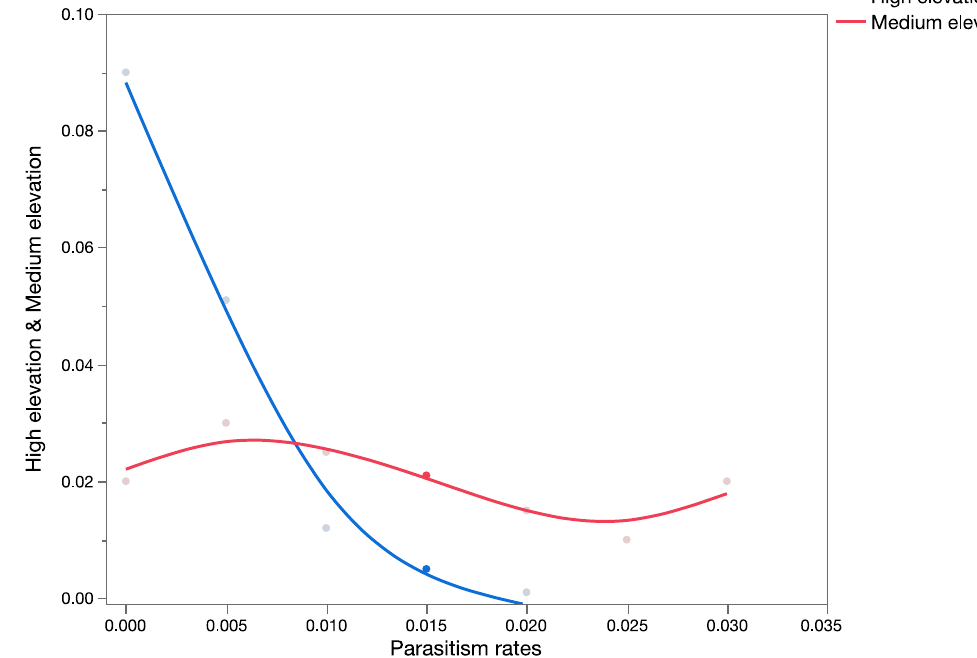
Figure 6. Overlay chart showing a forecast of all possible parasitism levels (as proportion on the x -axis) for M. laphygmae at medium- and high-elevation sites using field-collected data from Hawaii.